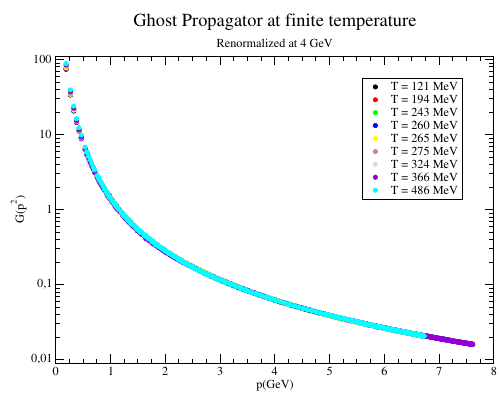
Figure 1. Renormalized ghost propagator at finite temperature.